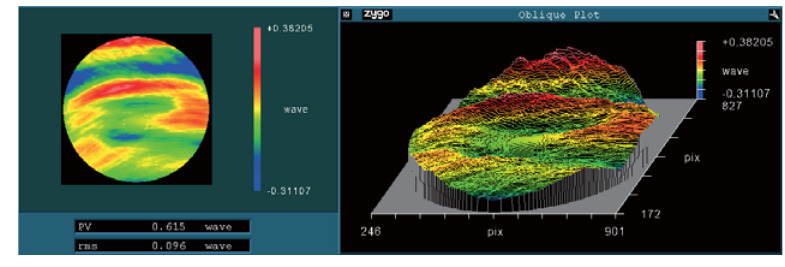
Figure 12. The test result of Φ 135 mm OAP: ( a ) auto-collimation; ( b ) single CGH; ( c ) hybrid